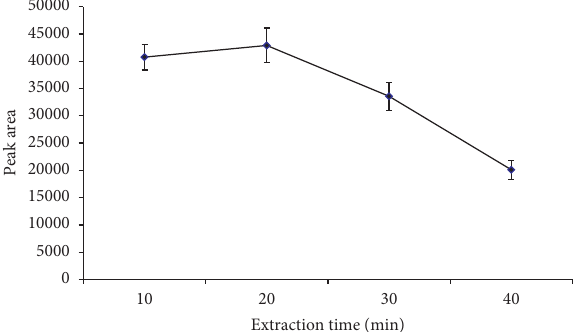
Figure 6: Effect of extraction time on extraction efficiency. Extraction conditions: PVC nanostructured membrane as the sorbent, de- sorption time 30min with 0.01M sulfuric acid as the desorption solvent, and sample volume 10 mL; no adjustment of sample pH.